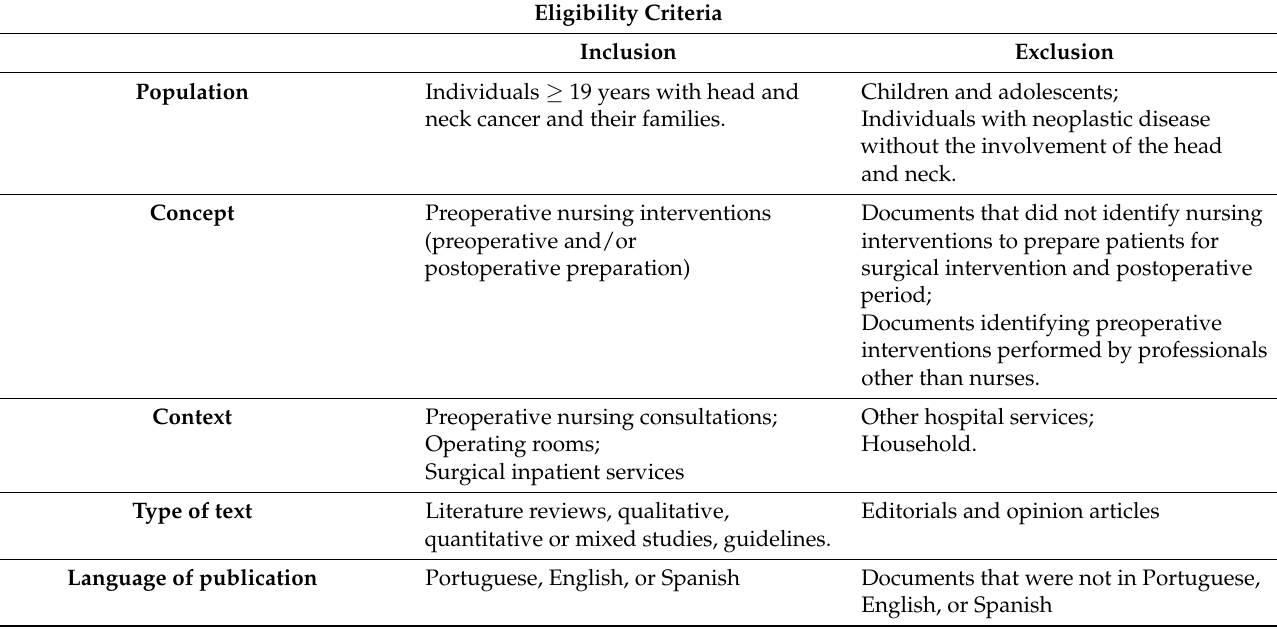
Table 1. Scoping review eligibility